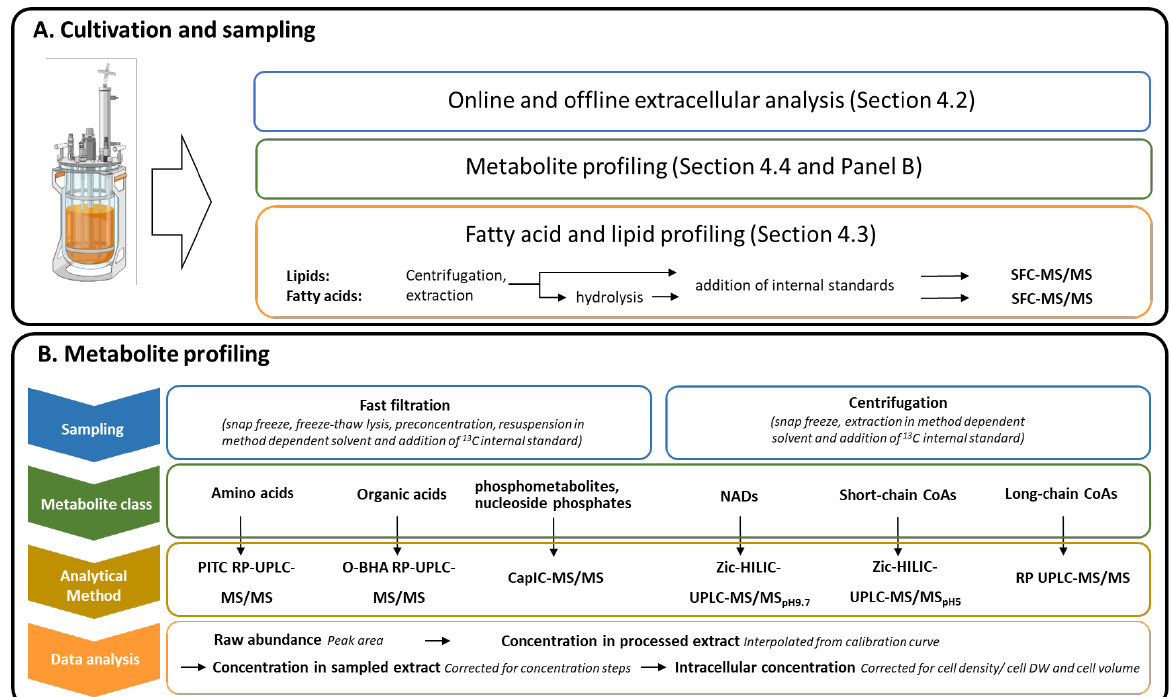
Figure 7. Three different sampling flows were removed from the 2-L bioreactor at appropriate time points to cover growth, transition and LA phases ( A ). A more detailed overview of the six methods metabolite profiling approaches ( B ). The bioreactor illustration was generated using a biorender template (biorender.com).